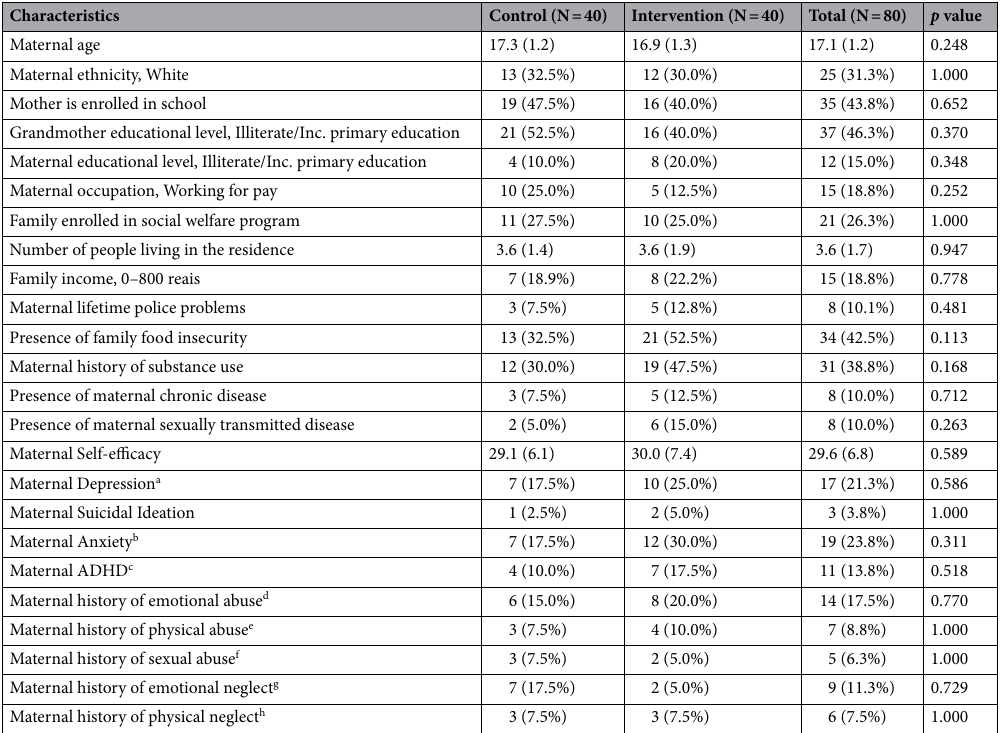
Table 1. Baseline characteristics of the sample. Data depicted as mean (SD) or N (%). ADHD attention-deficit/ hyperactivity disorder, ASRS ADHD Self-report scale, BAI Beck Anxiety Inventory, BDI Beck Depression Inventory, CTQ Childhood trauma questionnaire, Inc incomplete, M mean, SD standard deviation. a BDI